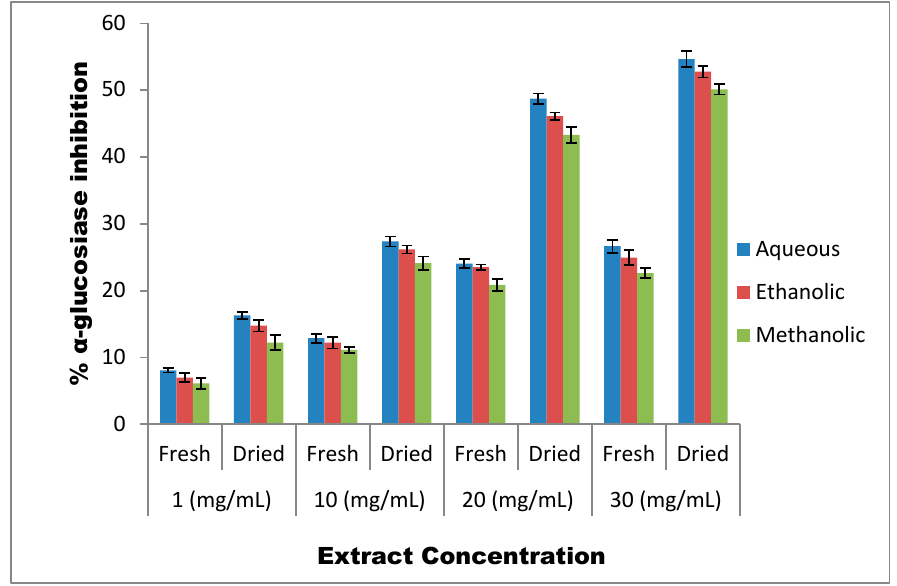
Figure 4. Percent α -glucosidase inhibitory potential of T. officinale extracts.